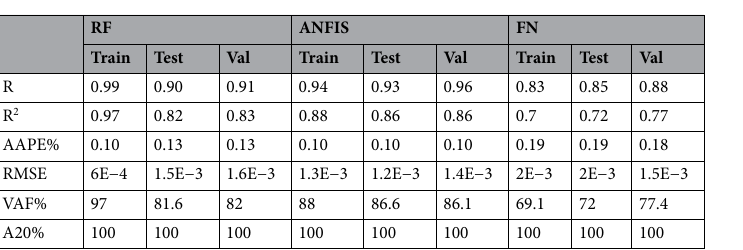
Table 4. Performance indicators summary for the training, testing, and validation datasets from the RF, ANFIS, and FN models to predict σ h from